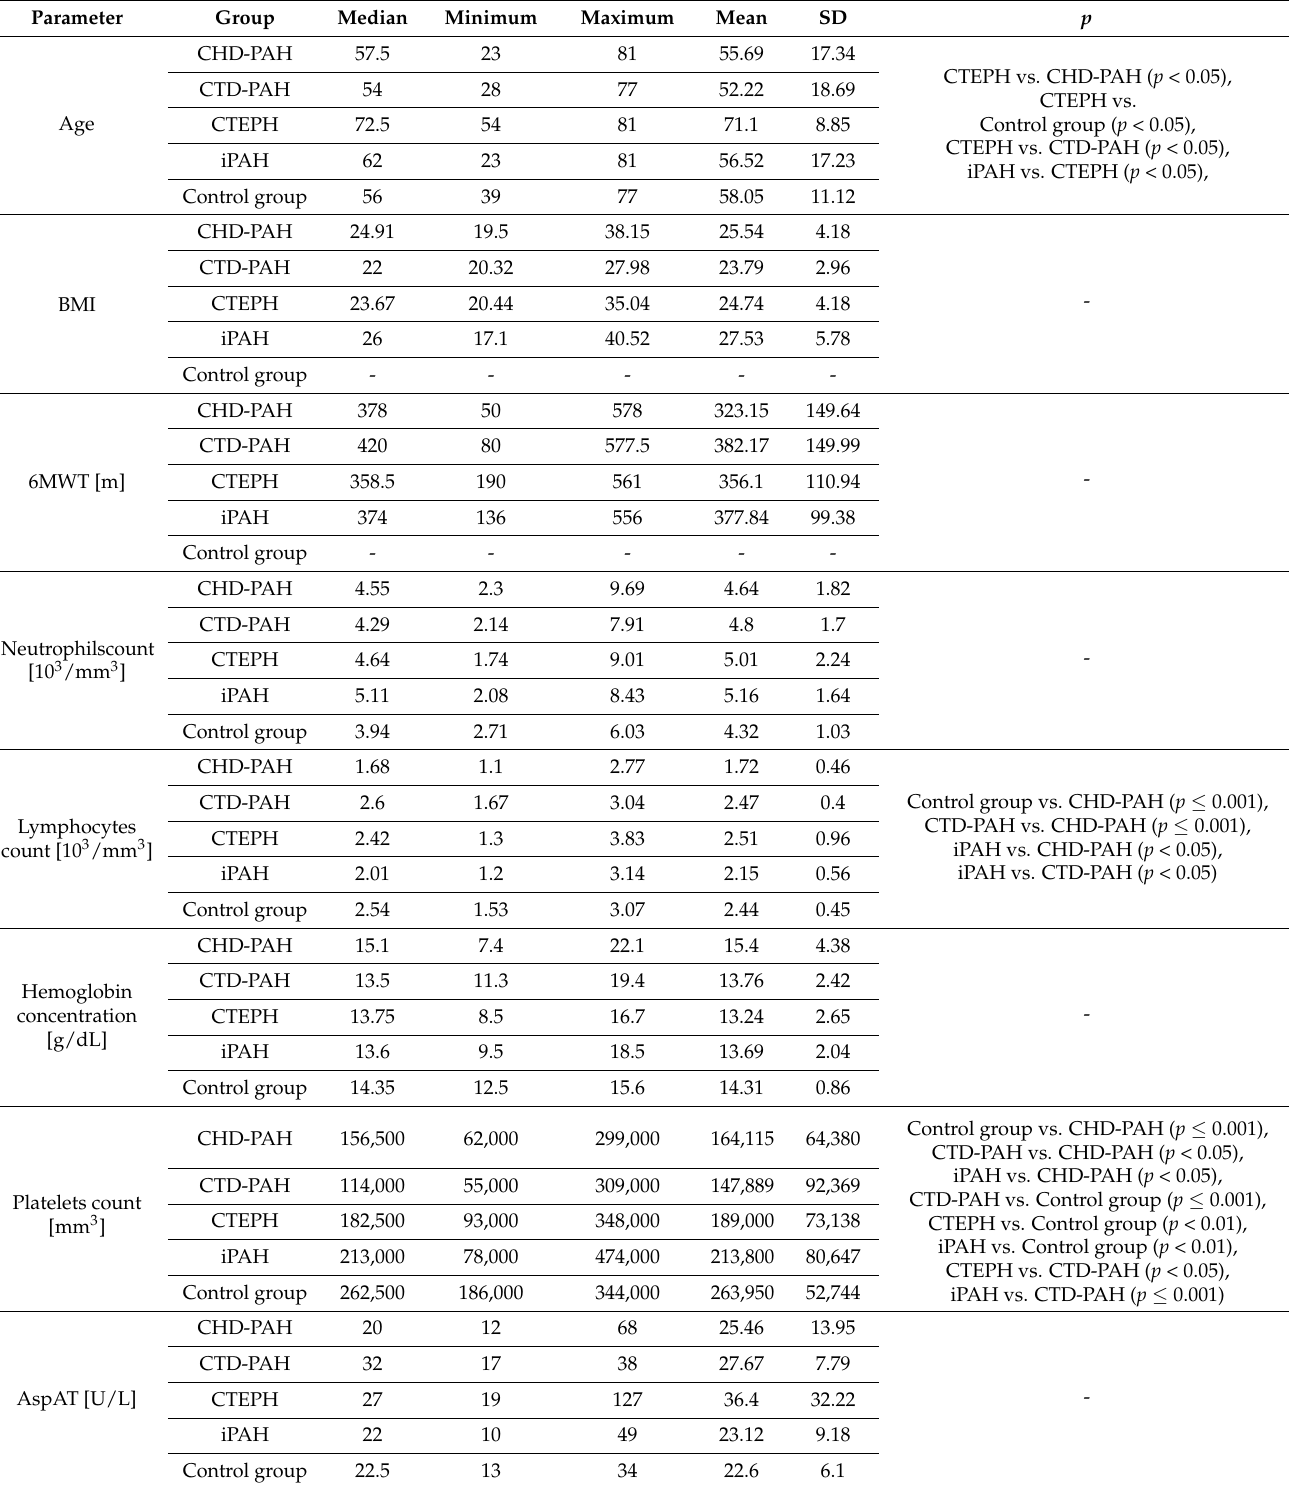
Table 2. Basic clinical and laboratory parameters characterizing patients with selected types of PAH and persons from the control